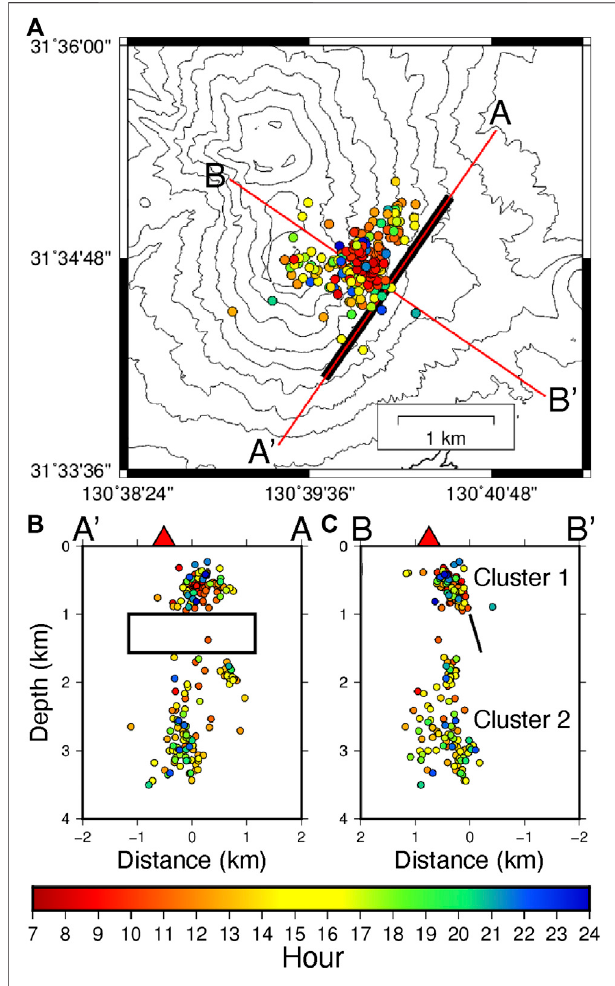
FIGURE13| HypocentersoftheVTearthquakesanddikesource(Hotta et al., 2016a) on August 15, 2015. (A) Map view of the hypocenters and location of the dike source. (B) and (C) show cross sections A – A ′ and B – B ′ parallel and perpendicular to the strike of the dike source, respectively. The open rectangle and solid line represent the location of the